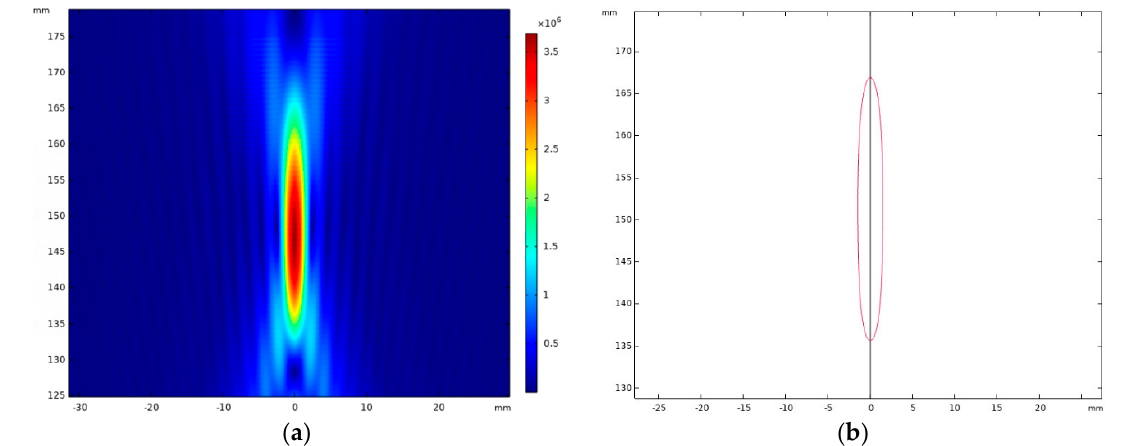
Figure 3. The simulation distribution of ( a ) peak positive pressure and ( b ) acoustic focal region in the r-z plane generated by the transducer.